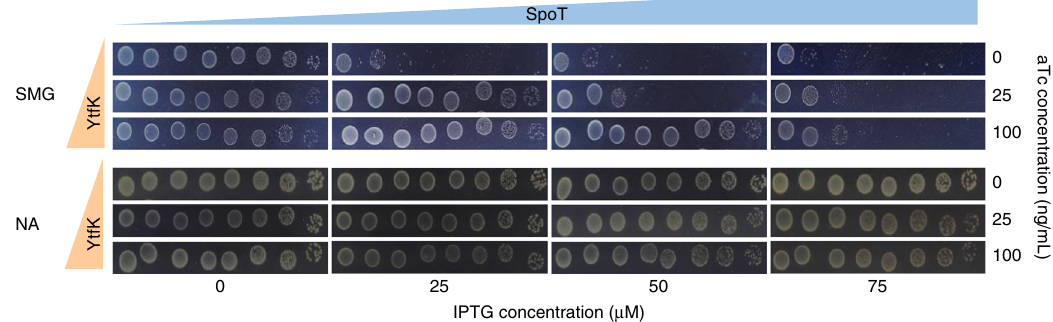
Fig. 2 The YtfK/SpoT ratio determines growth on SMG plates. WT strain was co-transformed with pEG25 harboring spoT gene under an IPTG-inducible promoter and with pBbS2K harboring ytfK gene under an anhydrotetracyclin (aTc) promoter. Cells were serially diluted and spotted both on SMG and NA medium with gradual concentration of IPTG (to induce spoT ) and aTc (to induce ytfK) . Additional controls with empty plasmids are provided in Supplementary Fig. 2. Experiments have been repeated four times with similar results.